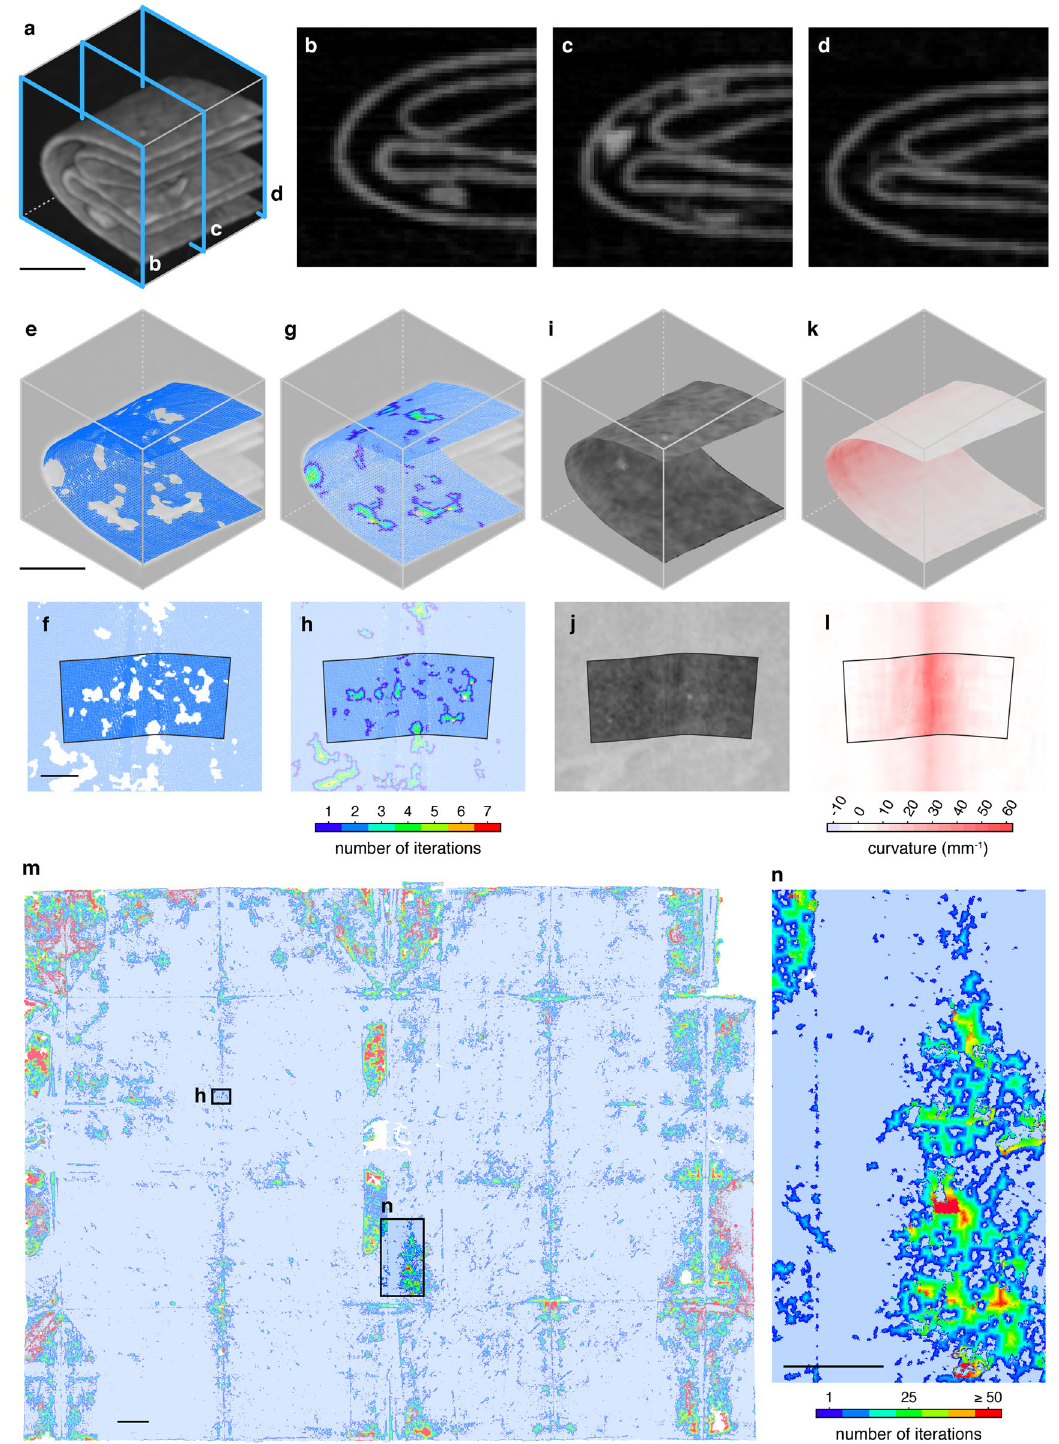
Fig. 4 Virtual unfolding pipeline. a Cropped 3D volume of DB-1538 XMT data showing three sections of folded paper; b – d three cross-sectional slices of the volume; e 3D segmentation result for outermost paper section; and f corresponding fl attened state. g 3D mesh after hybrid mesh propagation, with color indicating the order that new vertices were added to fi ll in segmentation holes, and h corresponding fl attened state. 3D mesh reconstruction colored with texturing results showing i greyscale XMT data image and k crease pattern image, and corresponding fl attened states ( j , l ). Black boundary in f , h , j , l shows the bounds of the 3D crop mapped to 2D. m Final fl attened reconstruction showing the initial segmentation result in pale blue with hybrid mesh propagation additions shown in a spectrum of colors according to the order in which new vertices were added. n A close- up reveals numerous isolated connected components in pale blue that were merged to form one continuous mesh during this process. Scale bars: a , e , f 1 mm, m 10 mm, n 5